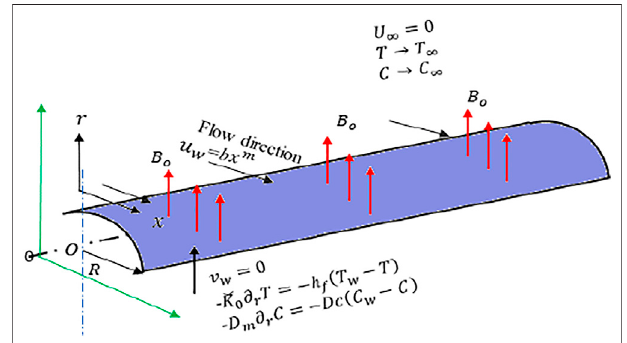
FIGURE 1 | Physical geometry of the